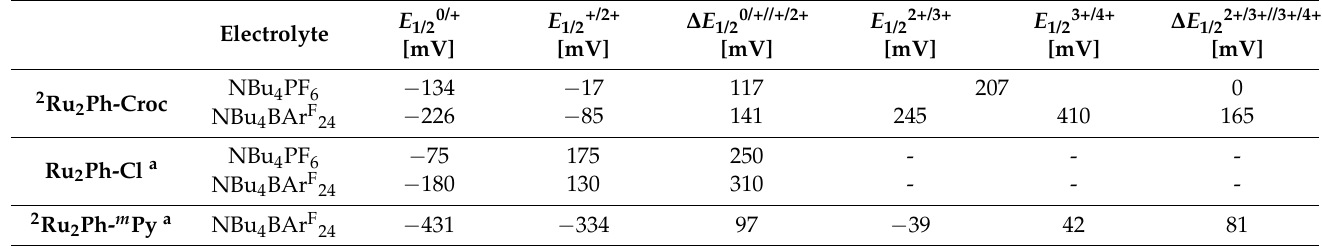
Figure 6. Anodic scans in the cyclic voltammograms of 2 Ru 2 Ph-Croc in CH 2 Cl 2 with either 0.1 M NBu 4 PF 6 ( left panel ) or NBu 4 BAr F 24 ( right panel ) as the supporting electrolyte. Table 1. Electrochemical data of 2 Ru 2 Ph-Croc in CH 2 Cl 2 in either 0.1 M NBu 4 PF 6 or NBu 4 BAr F 24 as the supporting electrolyte as well as comparative data for Ru 2 Ph-Cl and 2 Ru 2 Ph- m Py